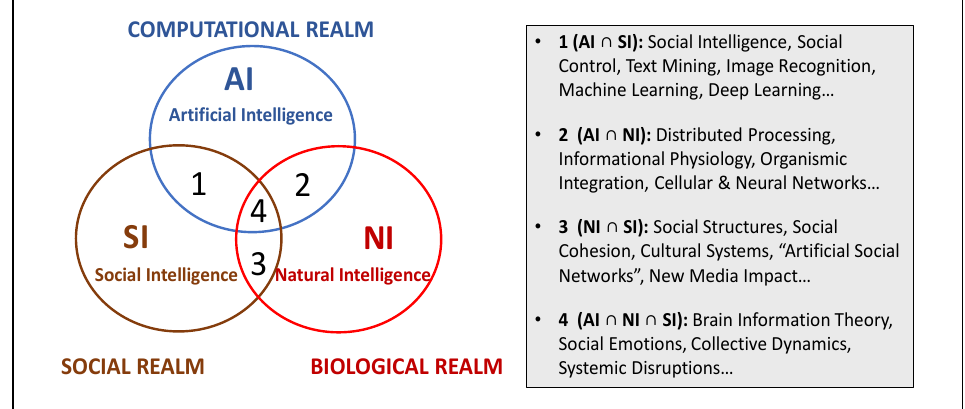
Figure 1. The triune approach to intelligence: The three proposed domains of intelligence are showing their respective intersections. On the right part of the figure, possible contents of the different intersections are suggested.